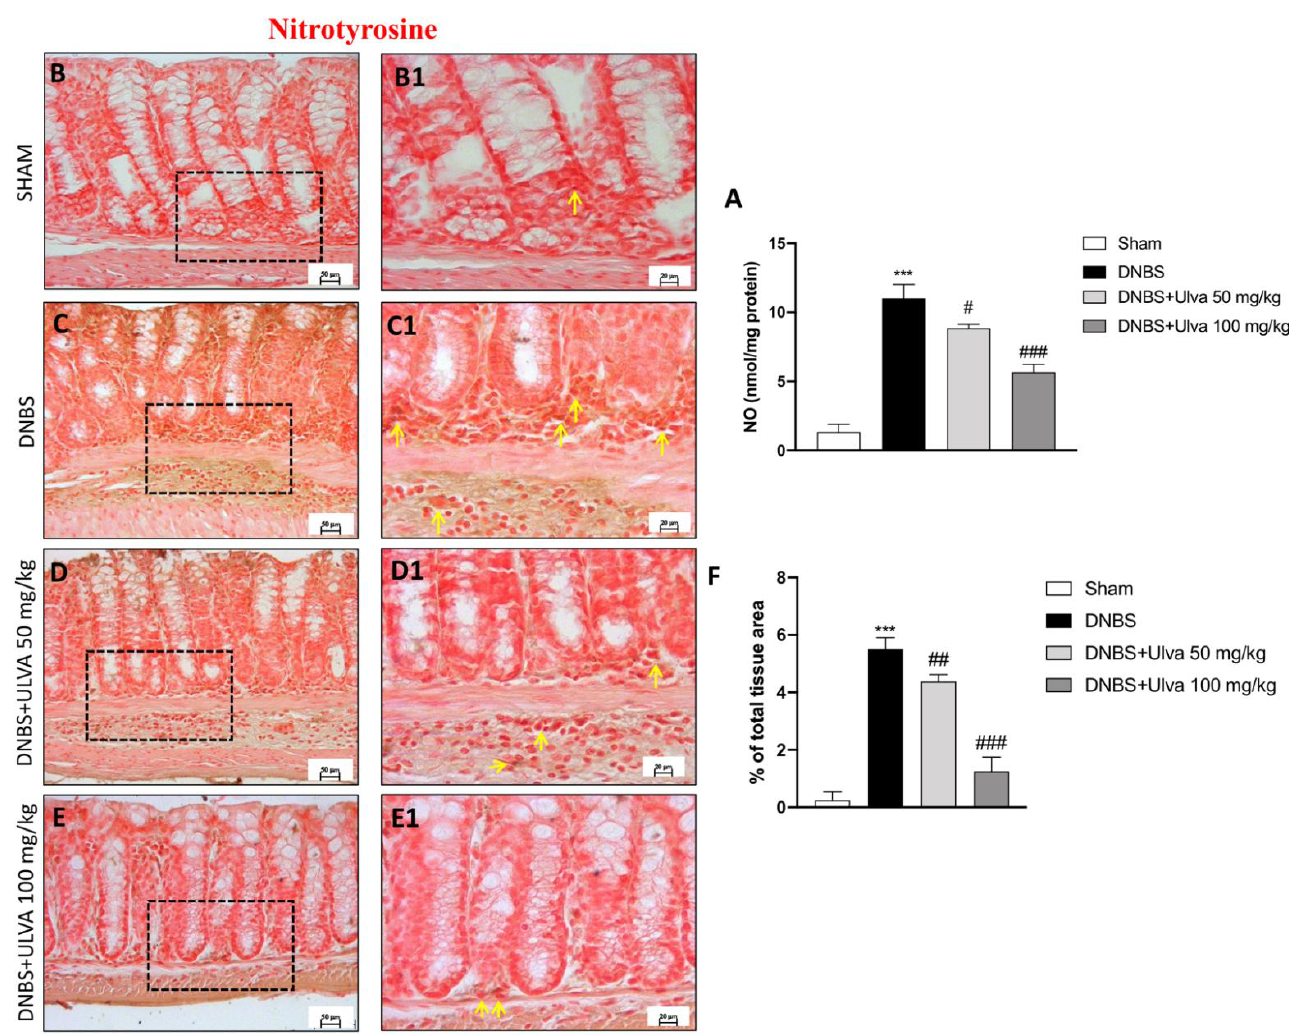
Figure 5. Effect of Ulva pertusa administration on Nitrotyrosine and NO levels. Positive Nitrotyrosine immunostaining was found in colon tissues collected from vehicle-treated mice ( C , C1 ), score ( F ), compared to the sham-treated mice ( B ), 40 × magnification ( B1 ), score ( F ). Ulva 50 mg/kg treatment, but even more Ulva 100 mg/kg administration reduced this staining ( D ), 40 × magnification ( D1 ), ( E ), 40 × magnification ( E1 ), score ( F ). Concordant results were obtained from the NO assay ( A ). Yellow arrows indicate the positive staining for Nitrotyrosine. Data are representative of at least three independent experiments. Values are means ± SD. One-way ANOVA test followed by Bonferroni. *** p < 0.001 vs. Sham; # p < 0.05 vs. DNBS; ## p < 0.01 vs. DNBS; ### p < 0.001 vs.